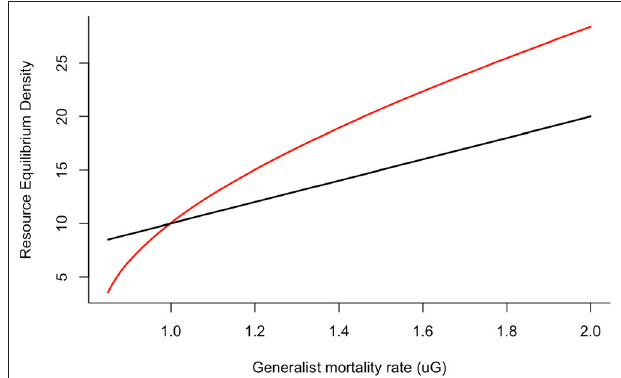
FIGURE 2 | Equilibrium density of the focal resource in the absence (black line) and presence (red line) of the alternative resource (U). When generalists are long-lived (low mortality), the abundance of the focal resource is lower in the presence of the alternative resource due to the effects of apparent competition. By contrast, when generalists are short-lived, the abundance of the focal resources increases beyond the level found in the absence of the alternative resource due to apparent mutualism. Other parameters were α 0.1 and U = =